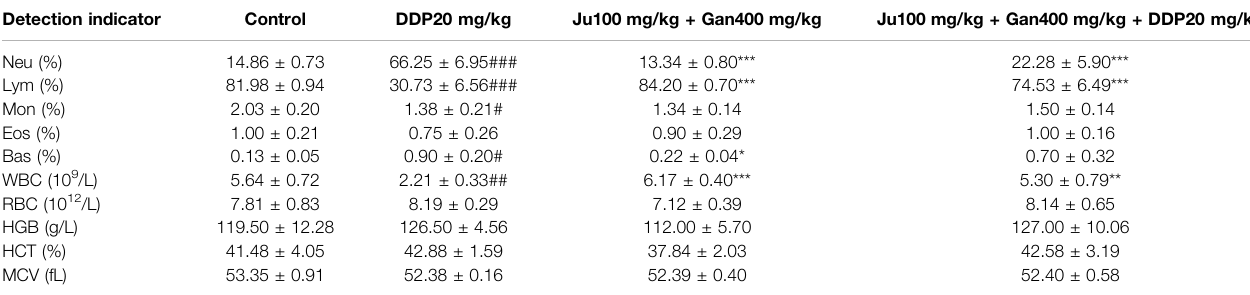
TABLE 6 | Blood cell analysis. Detection